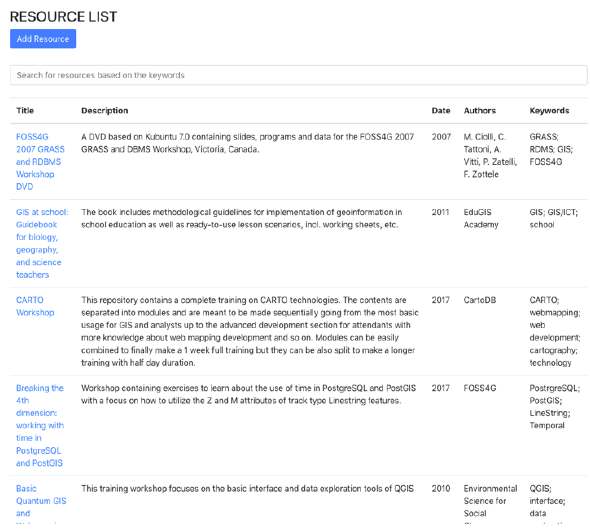
Figure 2. Current landing page of the catalogue displaying all